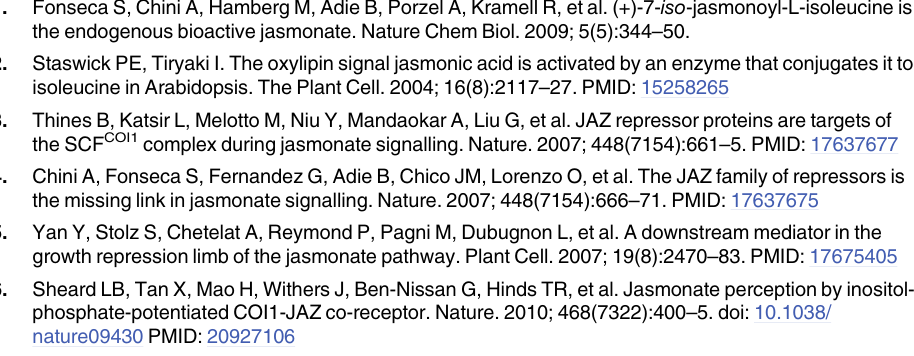
S3 Fig. Relative transcript levels of GRX480 (A) and ZAT10 (B) in leaves of Arabidopsis thaliana WS, opr3 , Col-0 and jar1 after treatment with OPDA or OPDA-Ile. Leaves of plants grown for 6 weeks under long-day conditions were floated on 30 μ M OPDA or 30 μ M OPDA-Ile for 30 min (white bars). Two independent controls (black bars) were performed by O containing 0.87% [v/v] and 0.56% [v/v] acetonitrile, respec- treatment with bi-distilled H 2 tively. Relative transcript levels were quantified by qRT-PCR using AtPP2A as reference. Each value is represented by the mean of three independent biological replicates ± SD. Treatments and controls were pairwise compared by the Student ’ s t-test, (cid:3) p (cid:1) 0.05, (cid:3)(cid:3) p (cid:1) 0.01, (cid:3)(cid:3)(cid:3) p (cid:1)